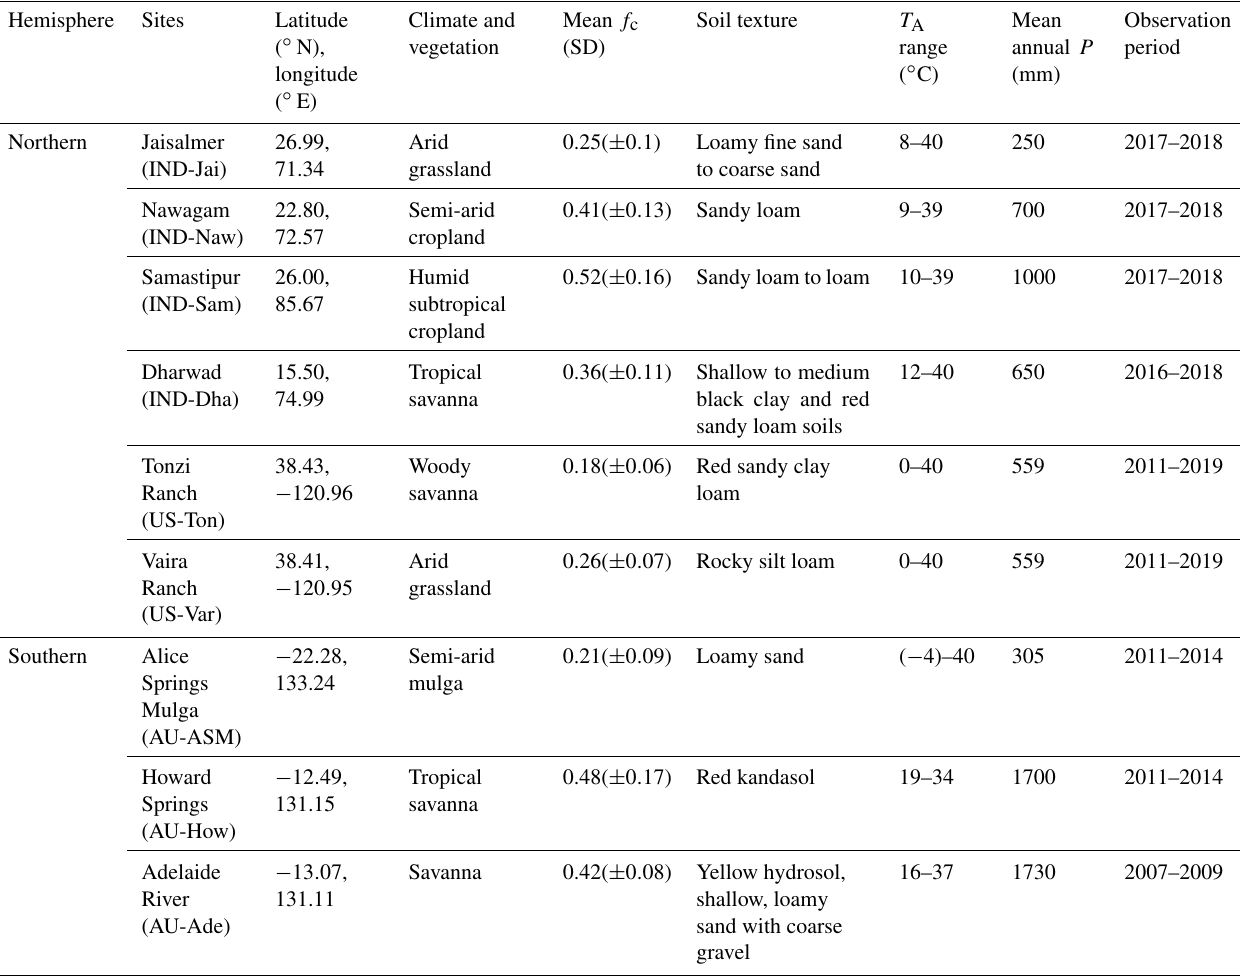
Soil texture Observation